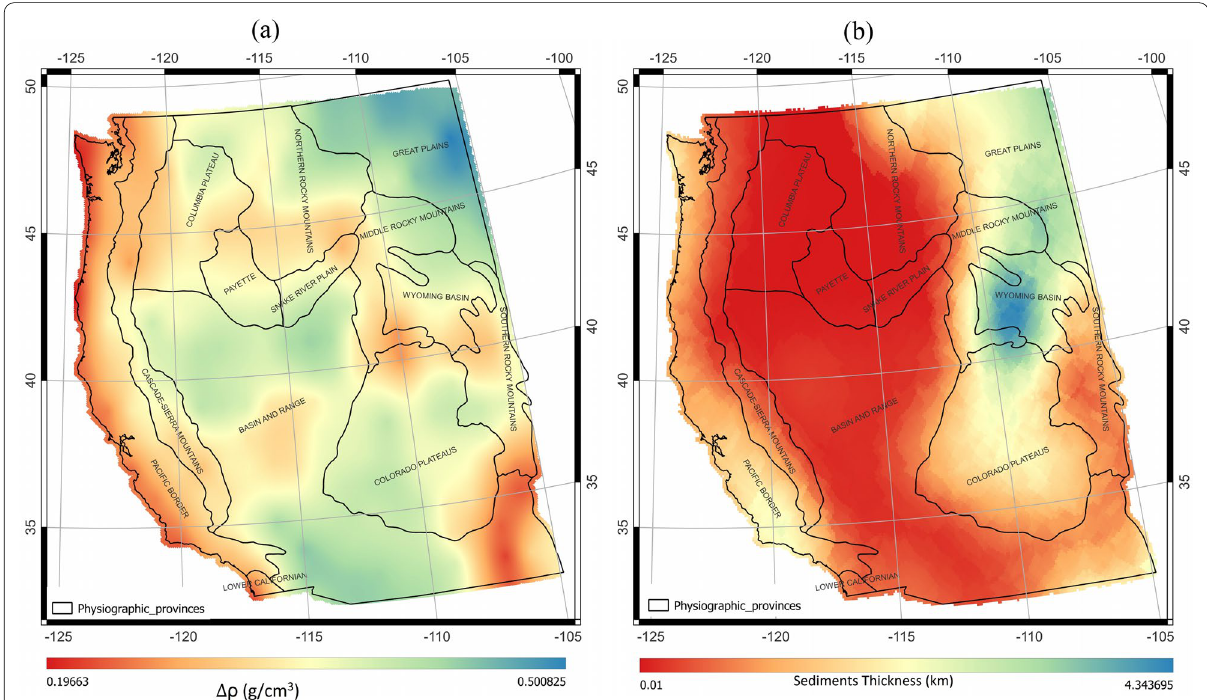
Fig. 4 a Density difference across the upper mantle and lower crust and b sediments thickness in the study